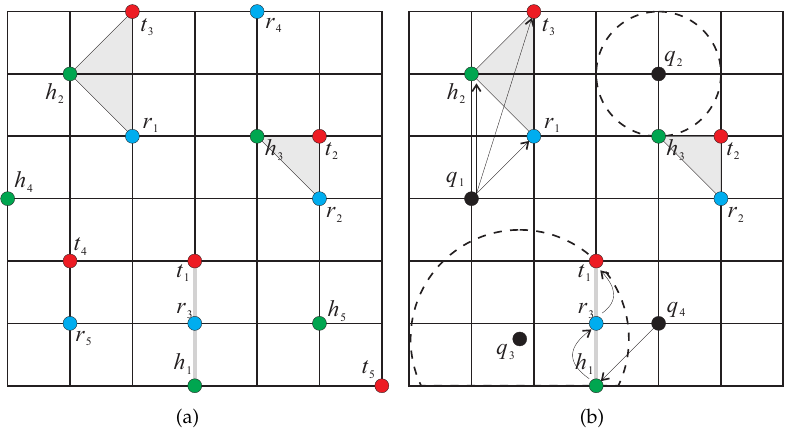
Figure 1. Example of processing the location-based aggregate queries. ( a ) Heterogeneous objects; ( b ) Multiple